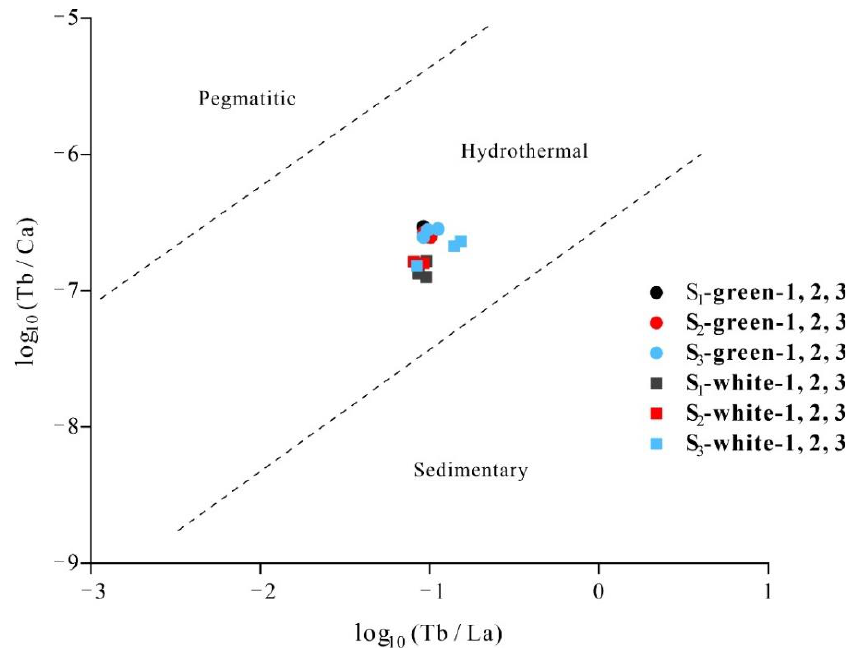
Figure 10. Tb/Ca-Ta/La discriminant plot of three cabochon specimens of Lvwen stone. Values represent atomic ratios rather than weight ratios.